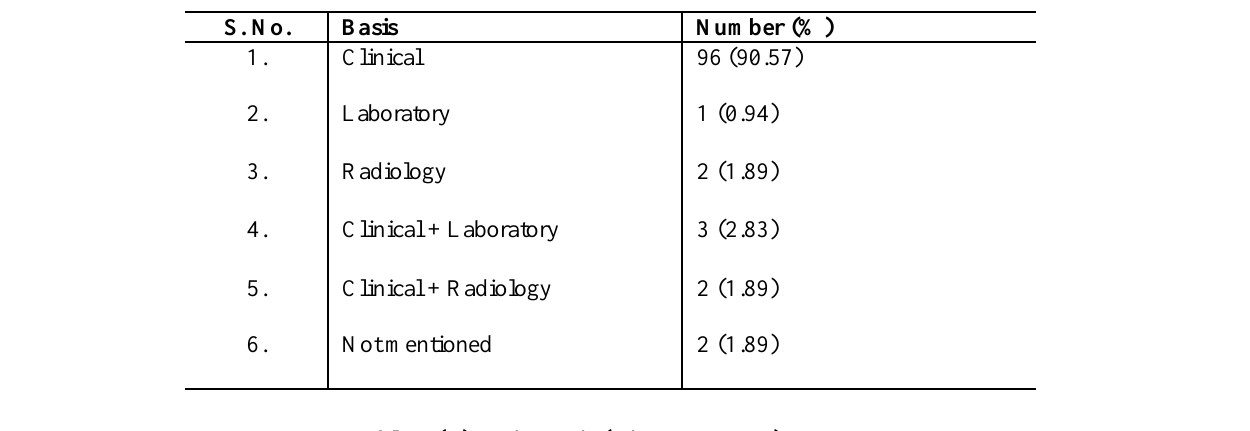
Table II(A) : Basis of diagnosis